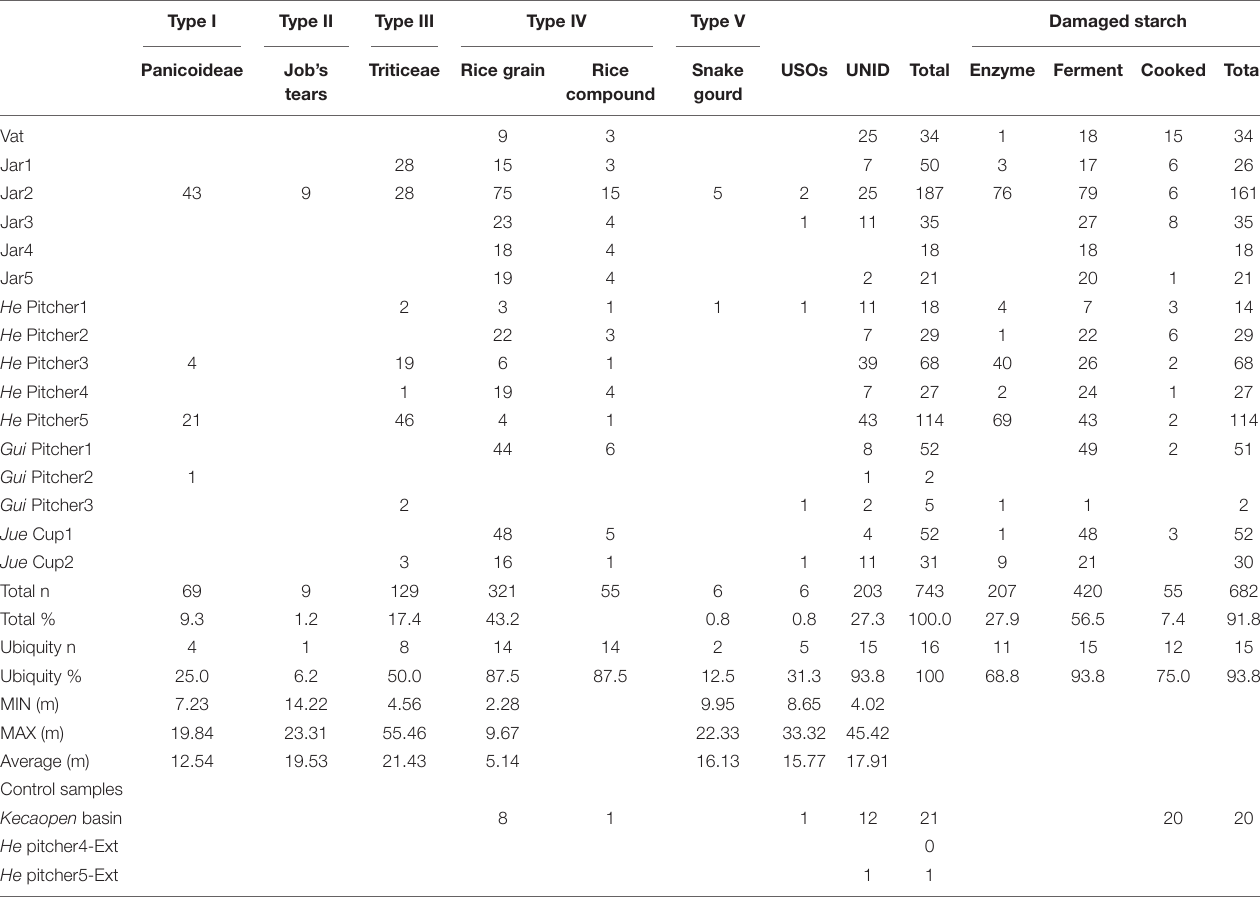
TABLE 2 | Erlitou starch